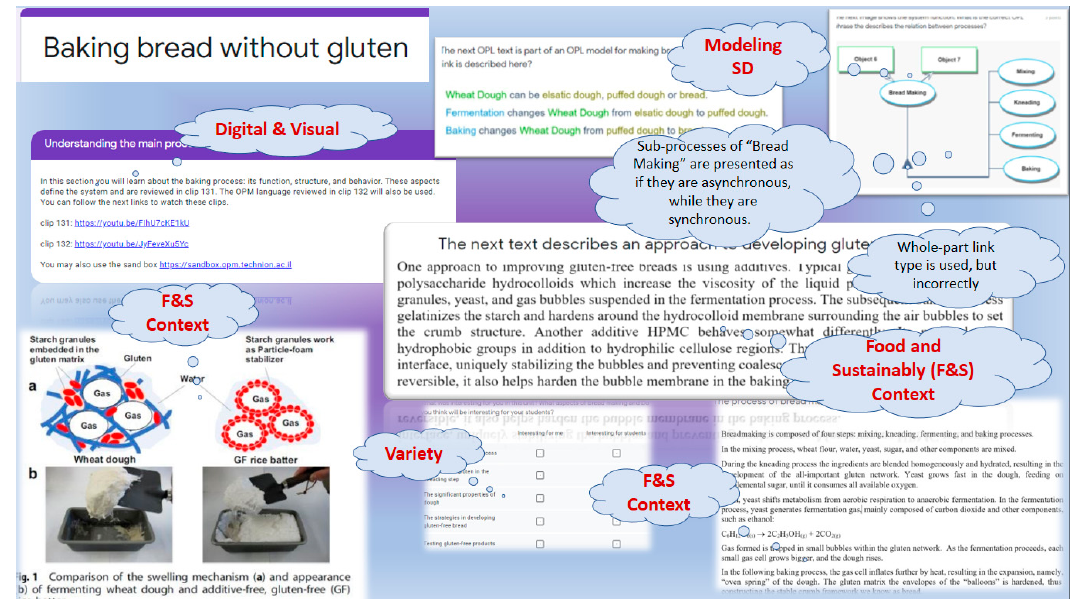
Figure 7. Selected segments of the final assignment submitted by participant # 112122201.